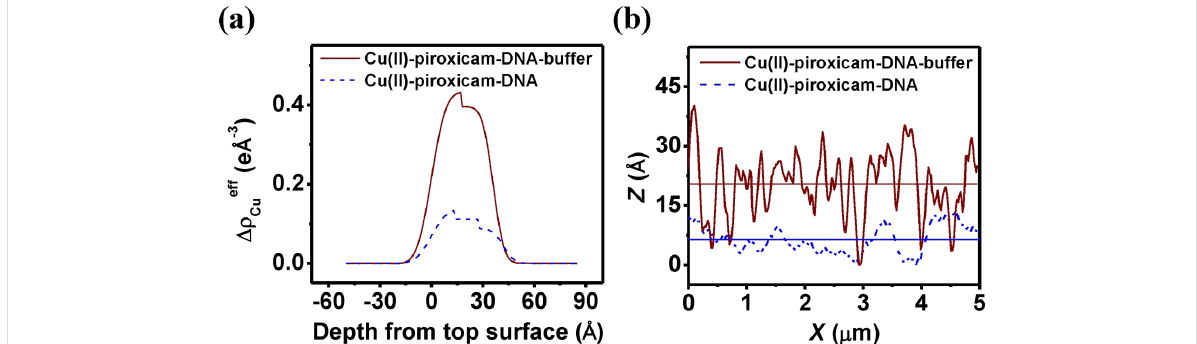
Figure 4: (a) Variation of Δρ Cueff along the film depth for both Cu(II)–piroxicam–DNA and Cu(II)–piroxicam–DNA–buffer films. (b) Comparison of the line profiles along the blue lines drawn on respective height images of Figure 2. The horizontal lines denote corresponding average heights of the profiles.